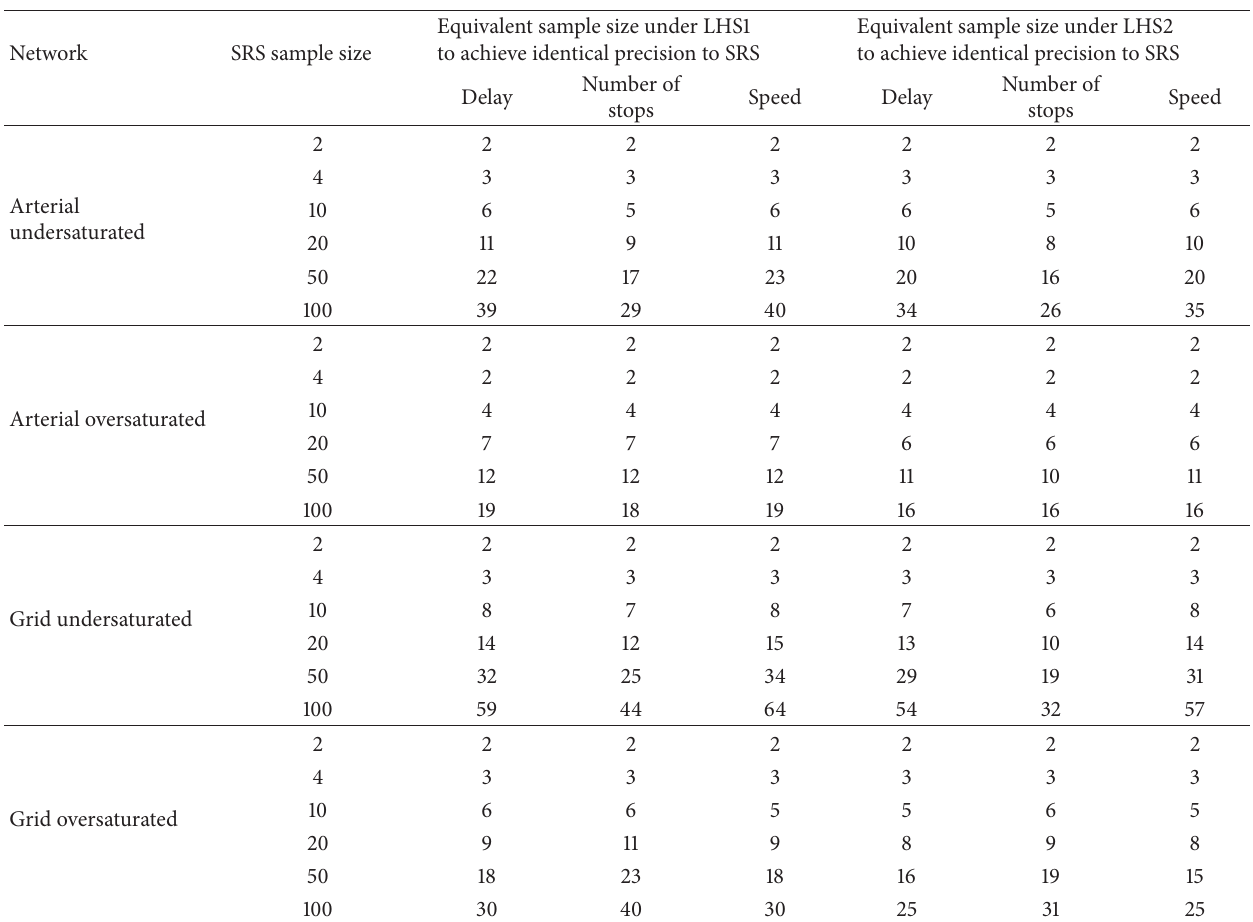
Table 4: Comparison of sample sizes under SRS and LHS for the same level of precision.